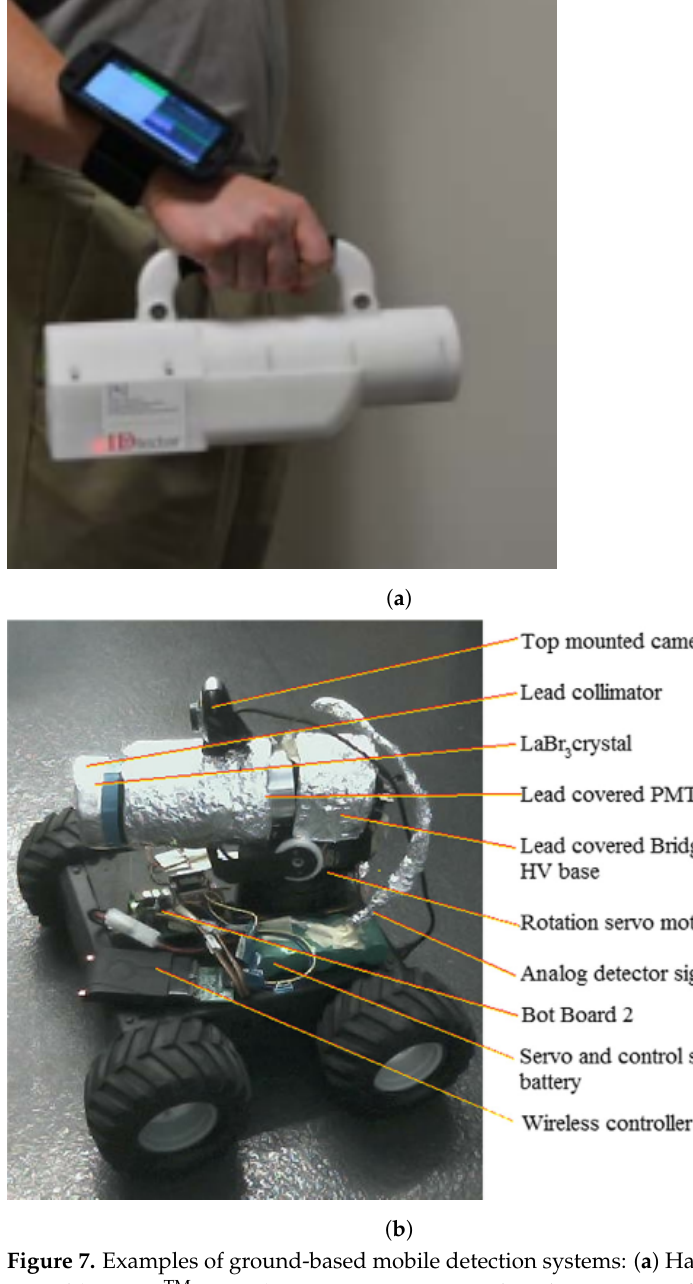
Figure 7. Examples of ground-based mobile detection systems: ( a ) Handheld detector using NaI(Tl) crystal (IDtector TM system). ©2015 IEEE. Reprinted, with permission, from Reference [131]. ( b ) LaBr 3 with a lead collimator mounted in a mobile robot. Reproduced, with permission, from Reference [134]; copyright Elsevier